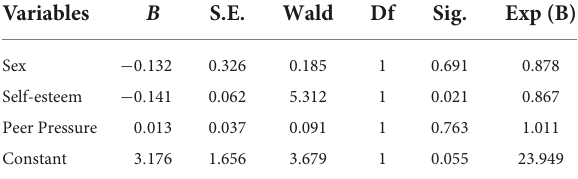
TABLE 4 Regression of attitude toward premarital sex on sex, self-esteem, and peer